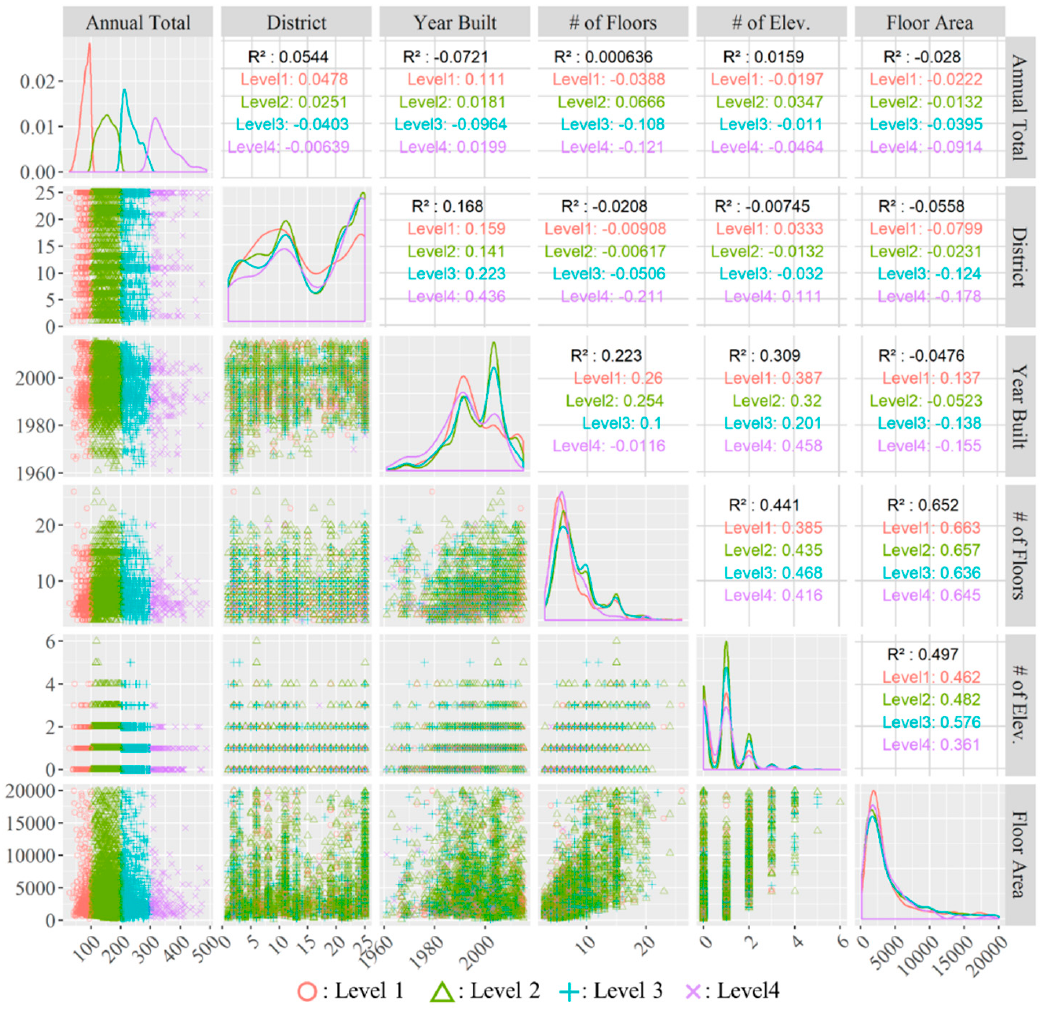
Figure 11. Scatter plot matrix, distributions, and correlation coefficients between building characteristics available in the Korean building energy database: district (an index of the 25 districts in Seoul), year built, number of floors, number of elevators, and floor area. (The ggplot2 package on R was used).